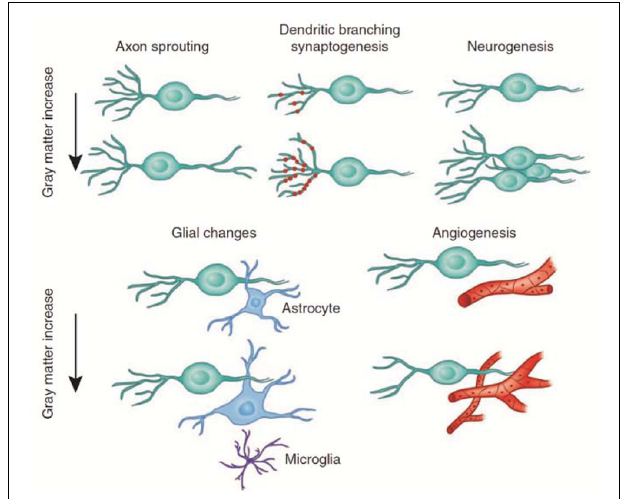
FIGURE 6 | Candidate cellular mechanisms for gray matter plasticity. Cellular events in gray matter regions underlying changes detected by magnetic resonance imaging during learning include axon sprouting, dendritic branching, and synaptogenesis, neurogenesis, changes in glial number and morphology, and angiogenesis (image courtesy of Marina Corral; modified with permission from Zatorre etal., 2012).